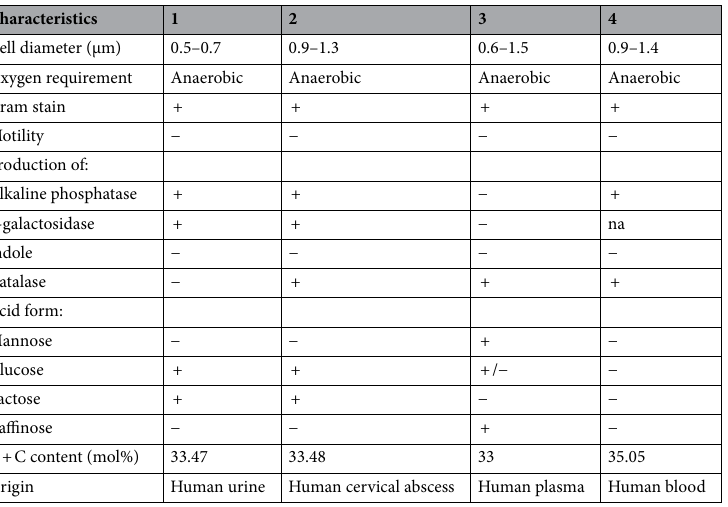
Table 2. Differential phenotypic characteristics of A. urinimassiliensis sp. nov, Marseille-P2143 T and related species of the genus Anaerococcus . 1 , A. urinimassiliensis sp. nov, Marseille-P2143 T ; 2 , A. provencensis 9402080 T ; 3 , A. prevotii DSM 20548 T ; 4 , A. pacaensis 9403502 T . + : positive reaction; -: negative reaction; na: not available.